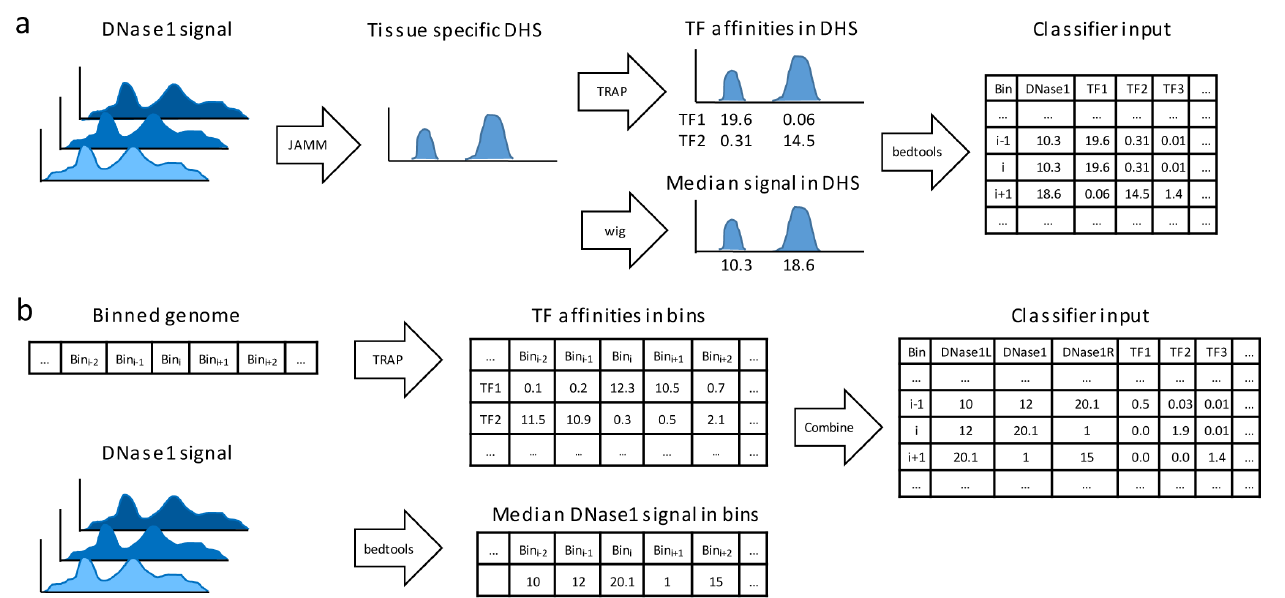
Figure 1. ( a ) Data pre-processing workflow using DNase1-seq Hypersensitive Sites (DHSs). Using JAMM, DHSs are called considering all available replicates for a distinct tissue. Transcription factor (TF) affinities in the identified DHSs are computed using TRAP for 557 TFs, the median signal of DHSs is assessed using bedtools. ( b ) An alternative data pre-processing workflow without DHSs: TF affinities and median DNase1-seq signal are computed per